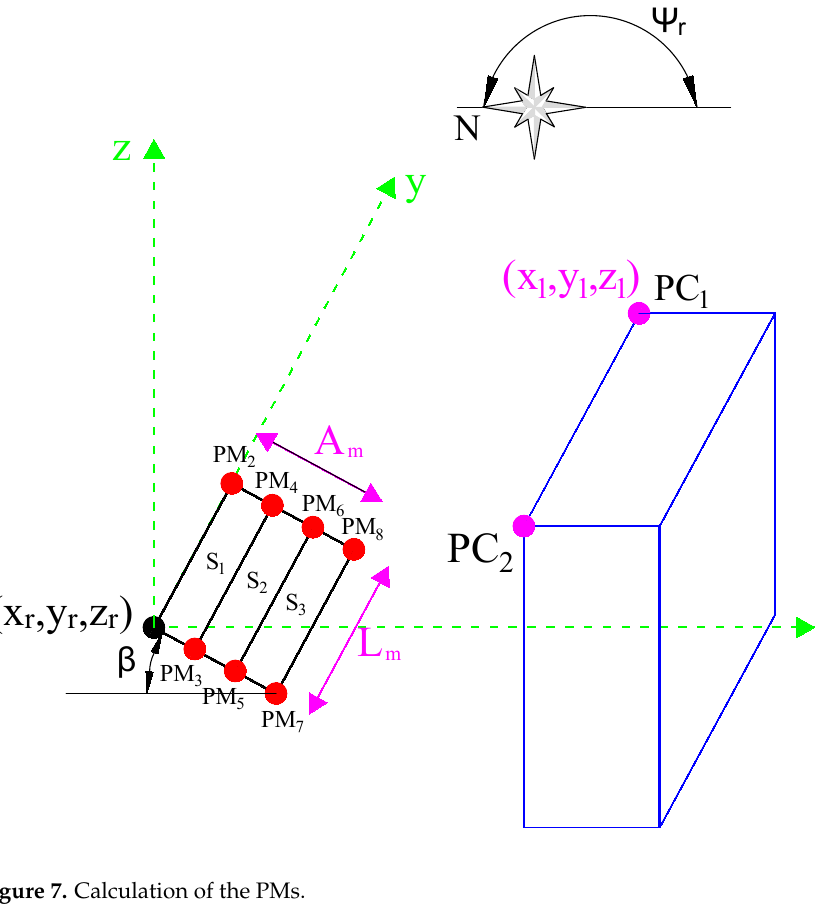
Figure 7. Calculation of the